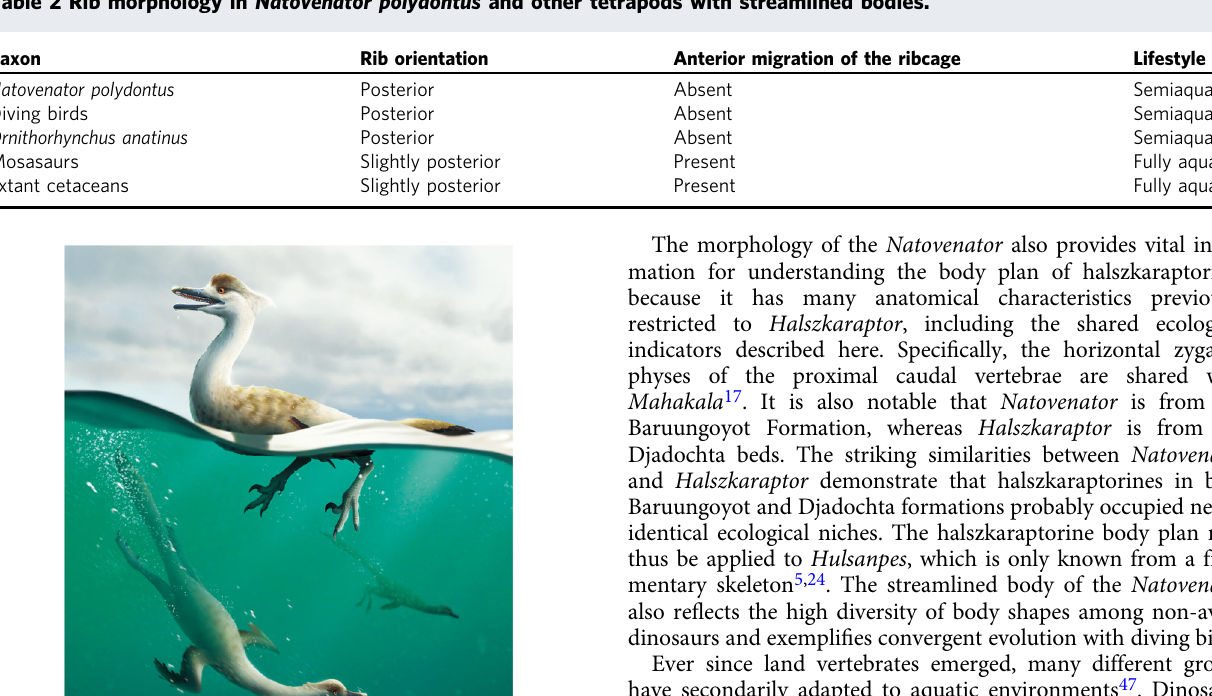
Table 2 Rib morphology in Natovenator polydontus and other tetrapods with streamlined bodies.